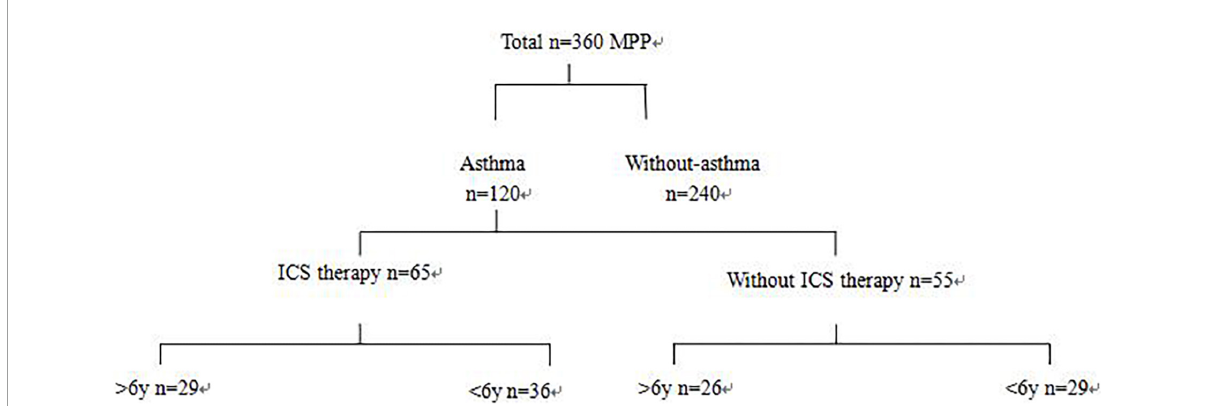
FIGURE1 Chart for patient grouping. Three hundred sixty children hospitalized for MPP were retrospectively analyzed. Based on the history of asthma, 120 hospitalized MPP children with asthma were randomly selected, and 240 MPP children without asthma were selected as control. According to the history of treatment, children with asthma with MPP were further divided into two groups: ICS therapy and without ICS therapy